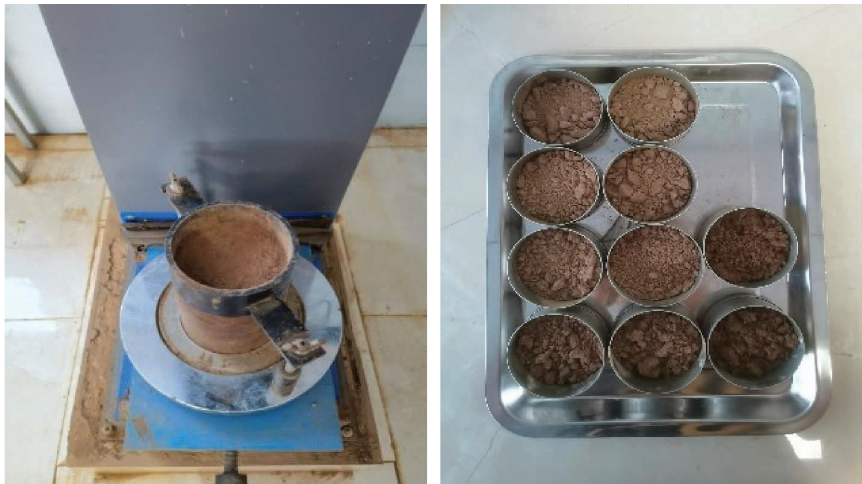
Figure 2: Heavy compaction test and optimum water content test.